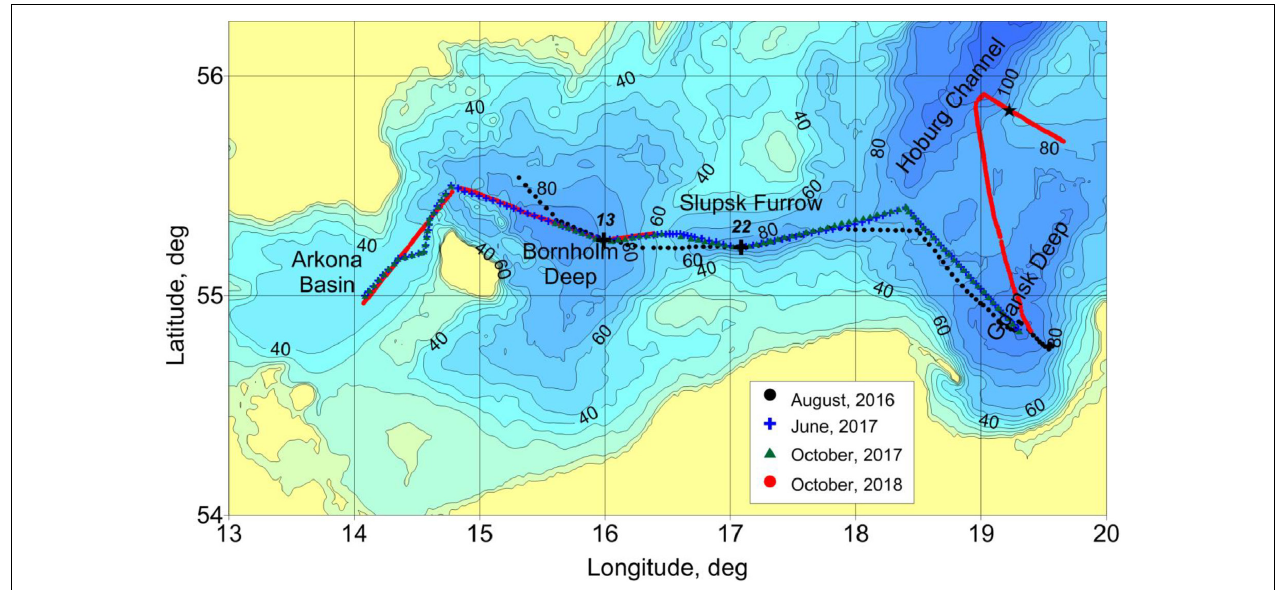
FIGURE 1 | Location of the transects (color lines), the TCM deployment site (black star), and the IOW main monitoring stations, TF0213 and TF0222 (black crosses labeled as 13 and 22, respectively).